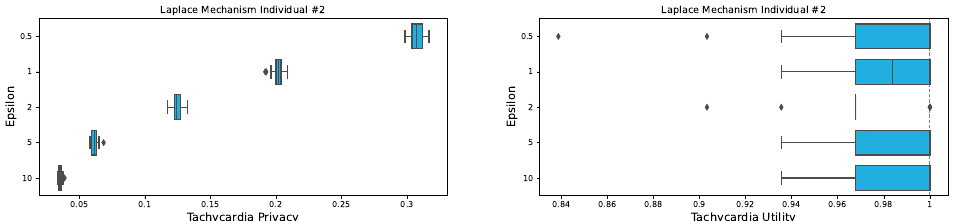
Figure 2. Box plots showing the Tachycardia Privacy (TP) and Tachycardia Utility (TU) for one individual using plain DP with Laplacian-distributed noise at 20 runs using a PIF = 3 for